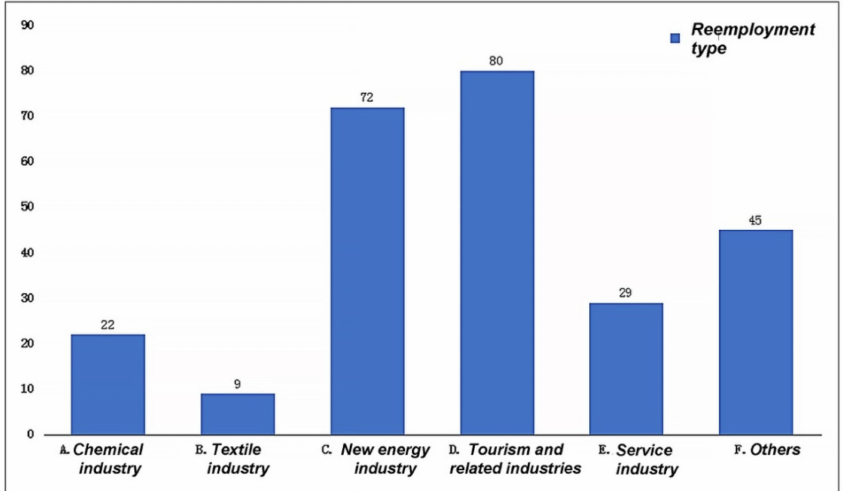
Figure 15. Residents’ intended